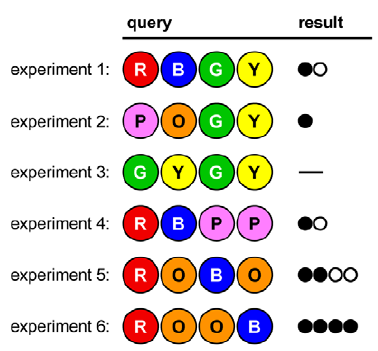
Figure 1. A sample game. See text for conclusions following from each